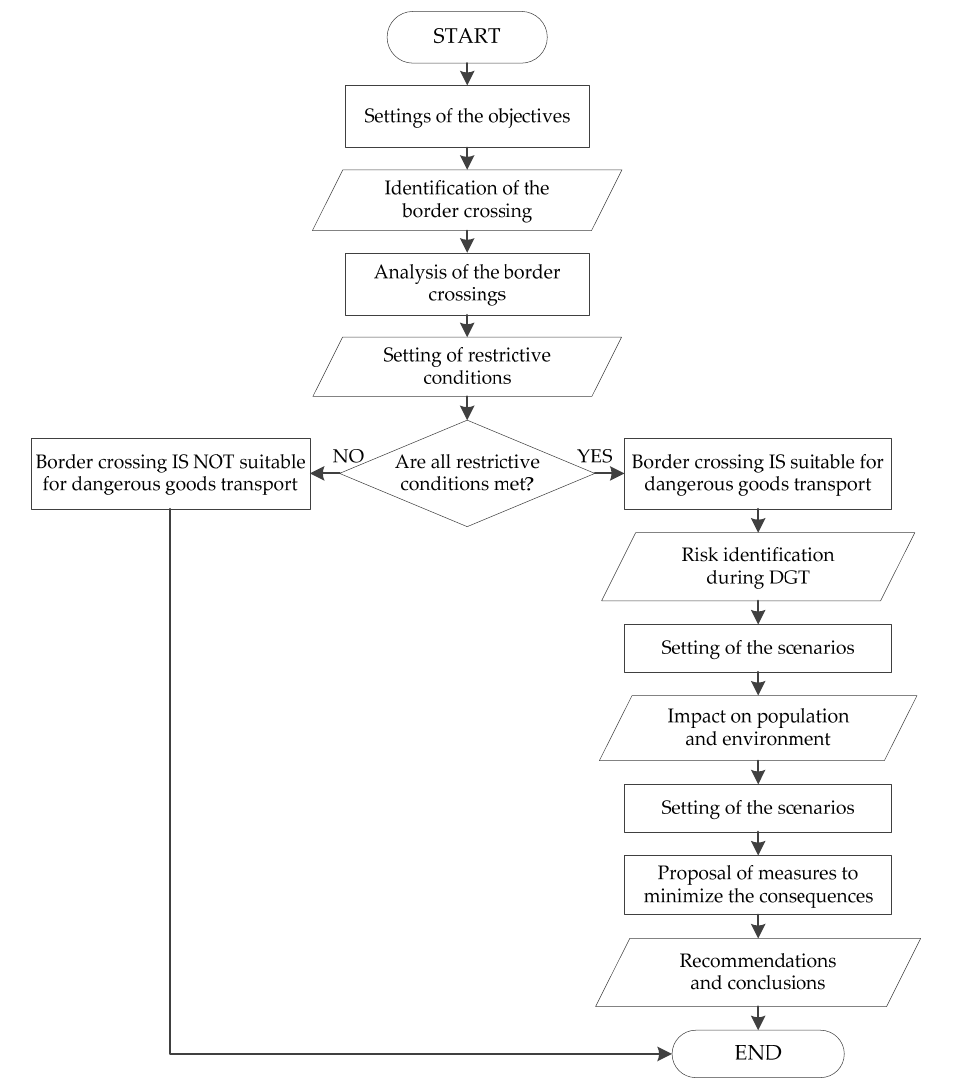
Figure 1. Scheme of the research processing procedure.